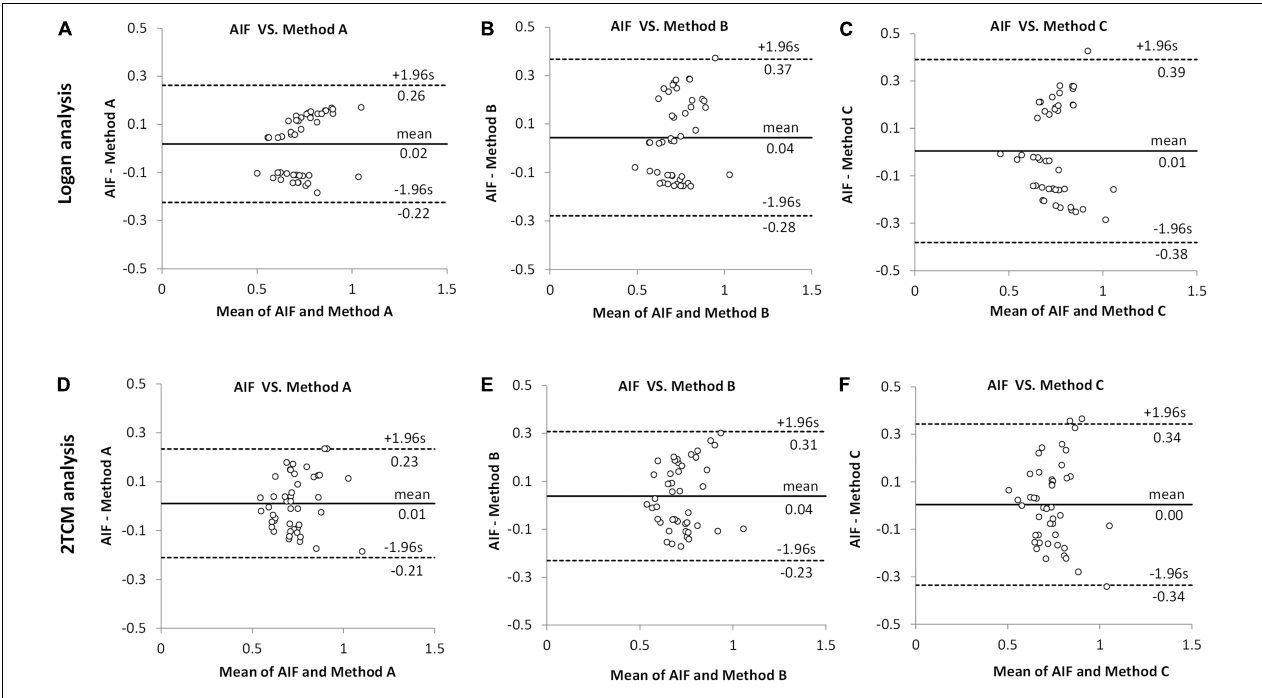
FIGURE 4 | Comparison between arterial input function (AIF) and image-derived input function (IDIF) of distribution volumes ( V T ) by Bland–Altman analysis. All V T values obtained by Logan and 2TCM kinetic modeling were the same as the data in Figure 3 . (A,D) The IDIF with the volume of interest (VOI) placed over the heart (method A) compared with AIF. (B,E) The IDIF with the VOI set over abdominal vena cava/aorta region with a cuboid (method B) compared with AIF. (C,F) the IDIF with the VOI delineated with 1 × 1 × 1 mm voxels on five consecutive slices over the abdominal vena cava/aorta region (method C) compared with AIF. Different dots represent different brain regions ( n = 9) in all mice ( n = 5).